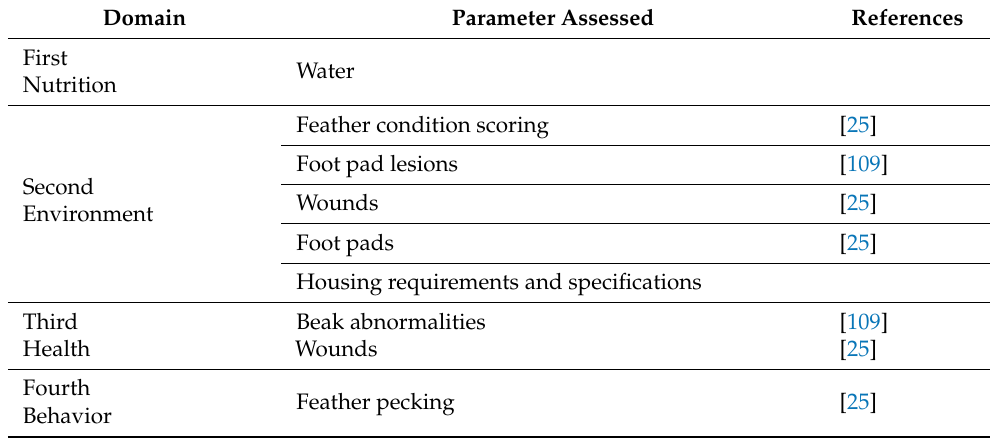
Table 4. Key Welfare Indicators for Laying